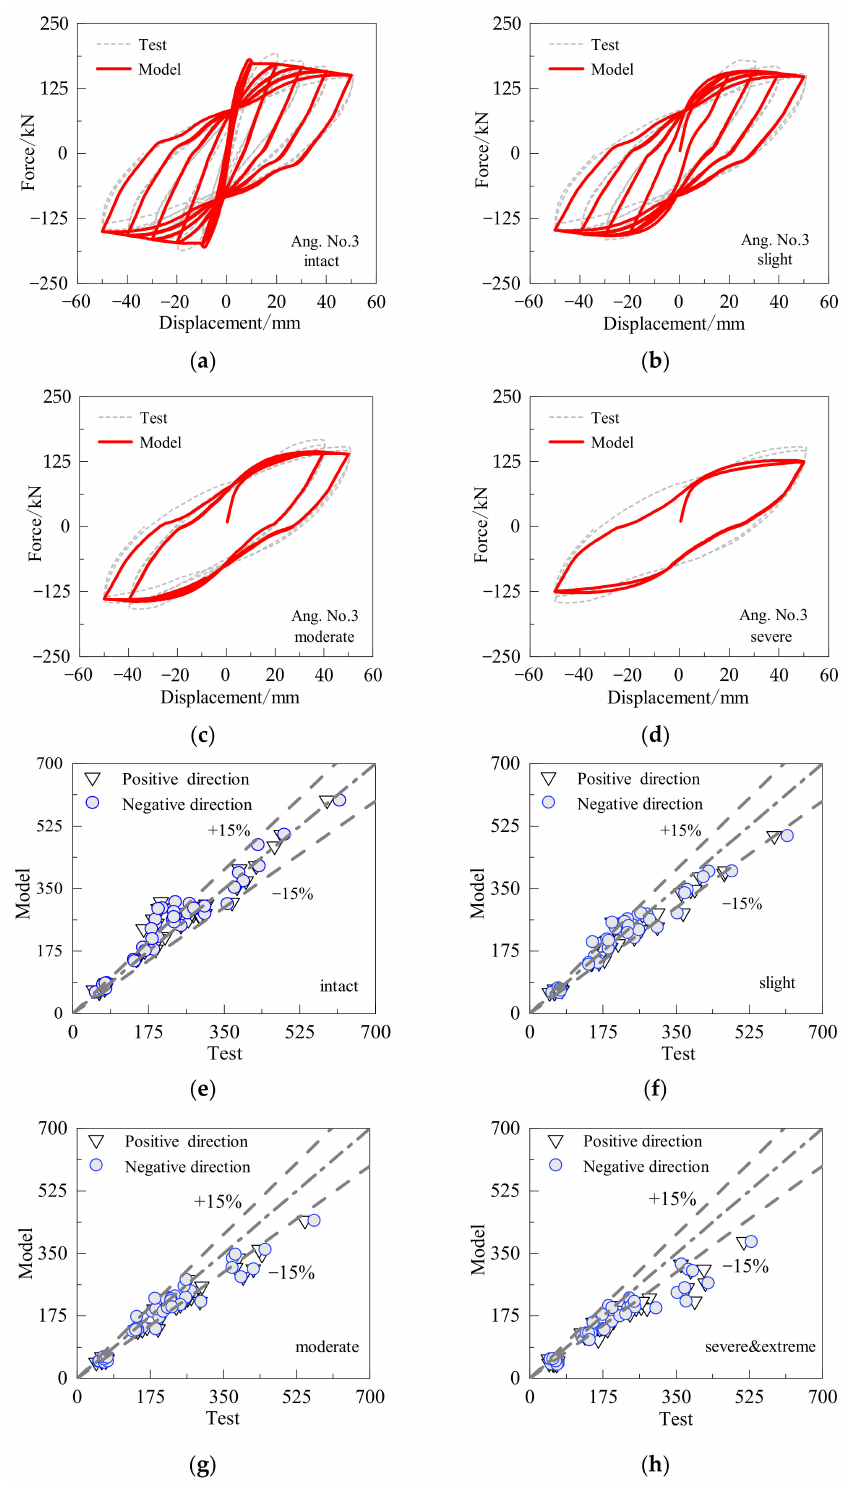
Figure 5. The residual load–displacement response of the seismic damage column Ang. No.3 and the residual bearing capacity of all the columns in different damage degree. ( a ) Response in the intact state. ( b ) Response in the slight damage state. ( c ) Response in the moderate damage state. ( d ) Response in the severe damage state. ( e ) The residual bearing capacity in the intact state. ( f ) The residual bearing capacity in the slight damage state. ( g ) The residual bearing capacity in the moderate damage state. ( h ) The residual bearing capacity in the severe and extreme damage